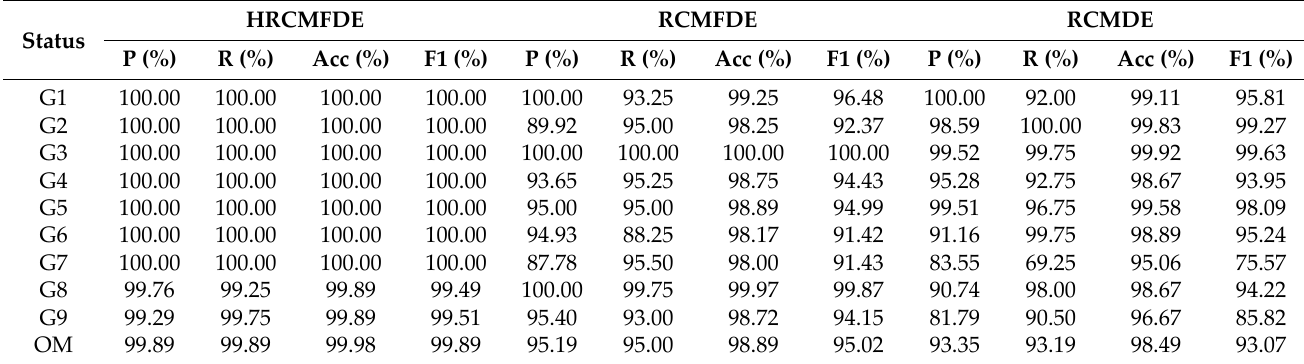
Table 15. Comparison of different